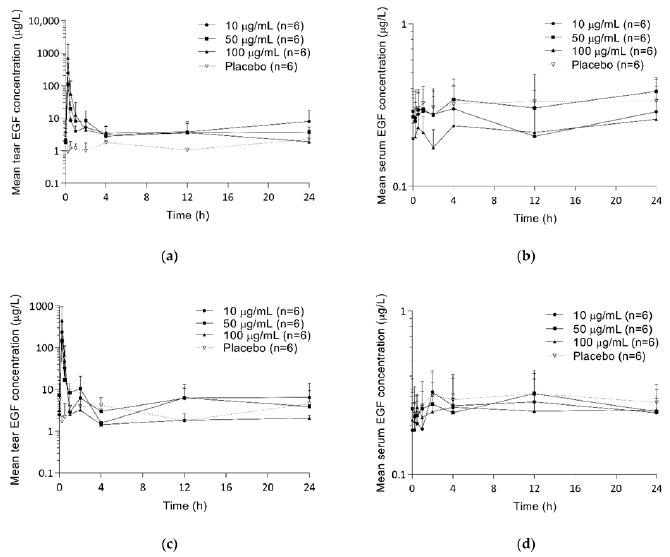
Figure 2. Mean EGF concentration-time curves after multiple administration of EGF eyedrops: ( a ) tear, day 1; ( b ) serum, day 1; ( c ) tear, day 14; ( d ) serum, day